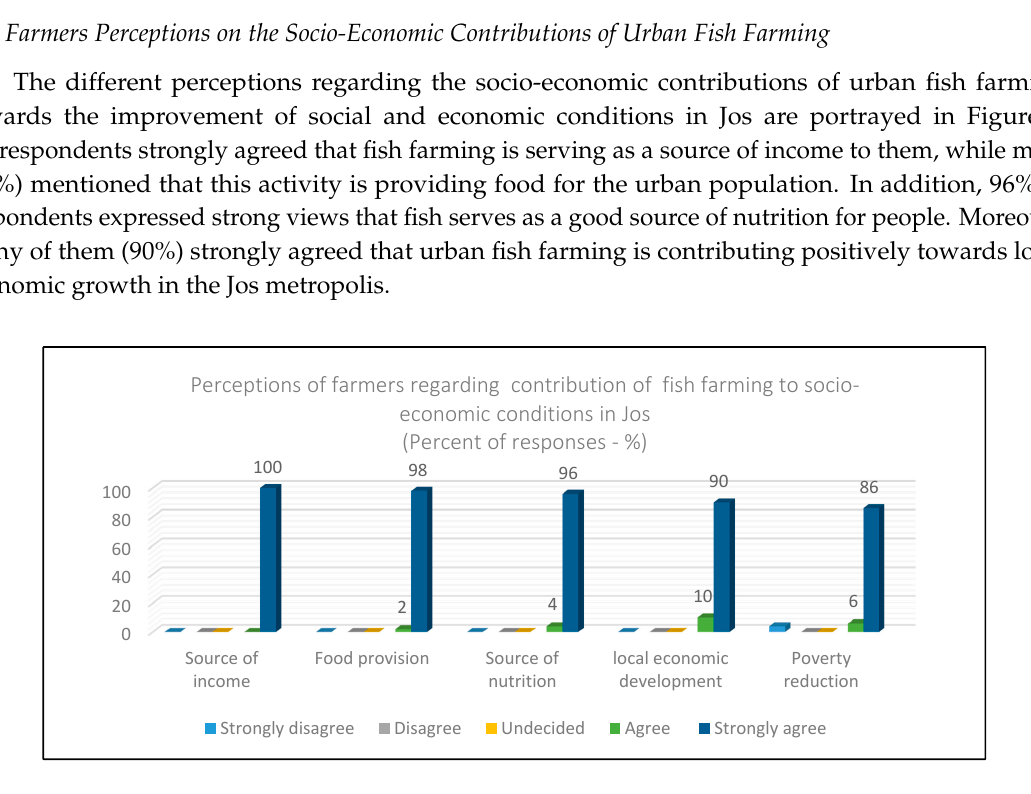
Table 3. Employment generated through fish farming in Jos.